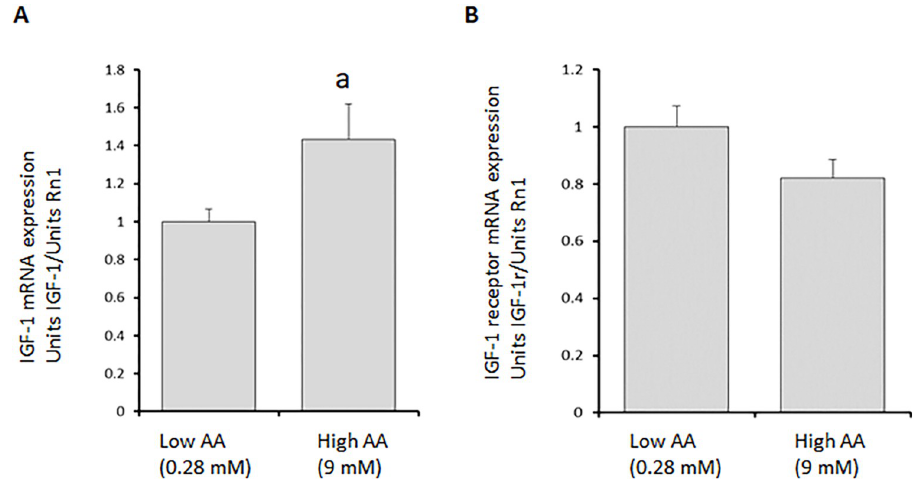
Fig 1. A and B. IGF-1 ( 1A ) and IGF-1 receptor ( 1B ) mRNA levels in Low (0.28) and High AA (9 mM) refed L6 skeletal muscle cells. IGF-1 mRNA levels increased significantly (p < 0.05), while IGF-1 receptor mRNA levels showed a decreased trend (p < 0.1). Confluent, non-proliferating L6 cells were subjected to starvation in very low amino acid media for 24 hours (0.14 mM) and then cultured in presence of either Low AA (0.28 mM) or High AA (9 mM) concentrations for 18 hours, followed by RNA extraction at the end of 18hrs incubation. mRNA levels were quantified by real time PCR as described in methods. Mean ± SE. a p < 0.05 n = 15/group.